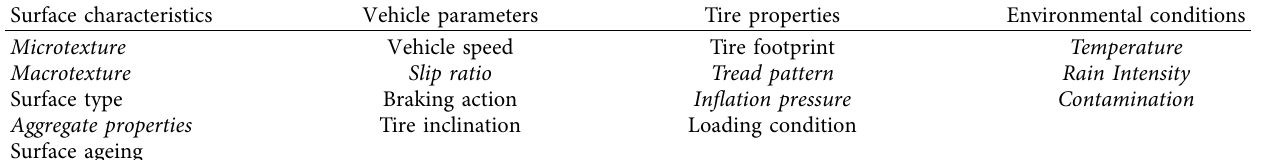
Table 4: Factors affecting available skid resistance at tire-pavement